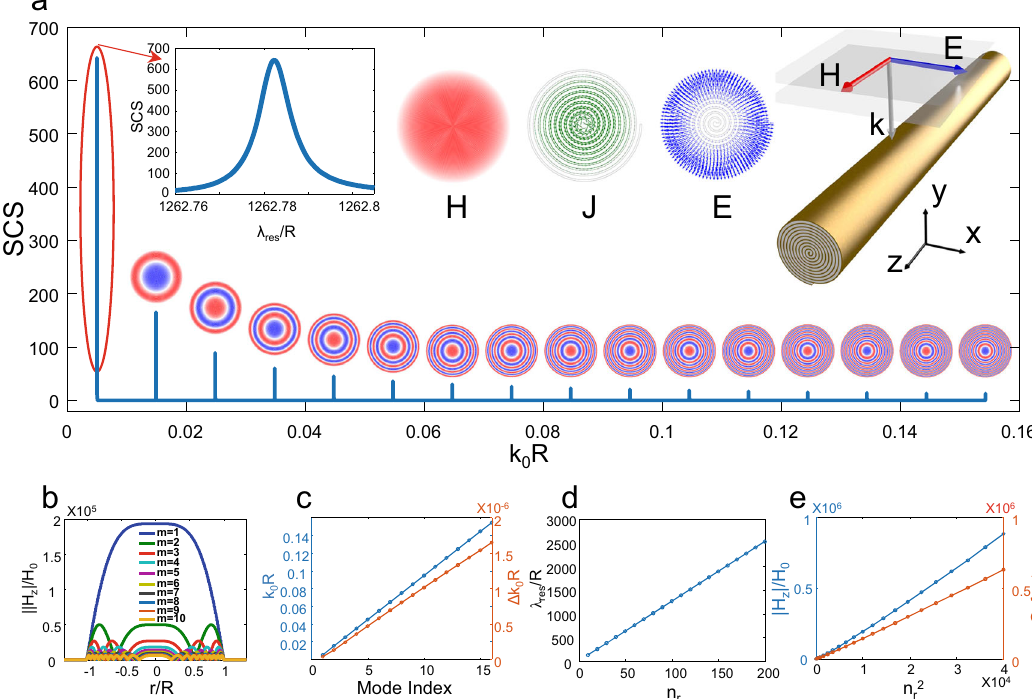
Fig. 2 2D spoof magnetic plasmons with near-equidistant multi-resonant response supported within a deeply subwavelength space-coiling cylinder. a Scattering spectrum of a PEC space-coiling cylinder with spiral turns n r = 100, duty cycle a / d = 2/3, illuminated by a TM plane wave. The upper insets show the enlarged scattering spectrum, magnetic fi eld ( H ), surface current ( J ), and electric fi eld ( E ) patterns of the fundamental mode, and schematic of the structure. The lower insets show the magnetic fi eld patterns for higher-order resonance modes. b Magnetic fi eld enhancement of the resonant modes along the radial direction, normalized to the impinging fi eld. c Normalized resonant frequency k 0 R of the fi rst 16 modes. d Resonant wavelength of the fundamental mode as a function of the spiral turn number n r . ( e ) Field enhancement and quality factor as a function of n r 2